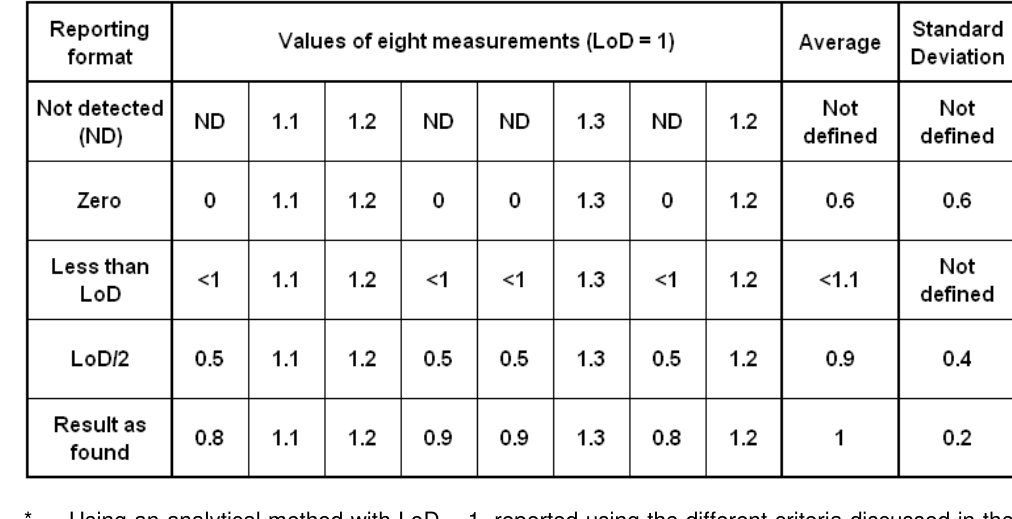
The Average and Standard Deviation of Eight